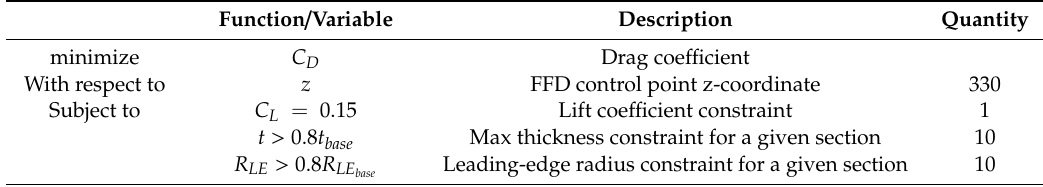
Table 8. Objective function definition.